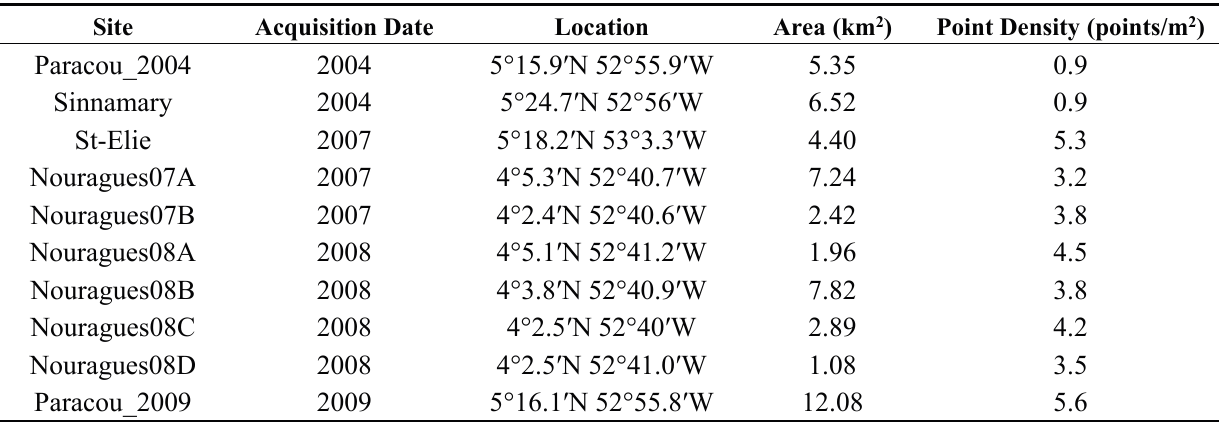
Table 1. Description of the HD datasets used in this